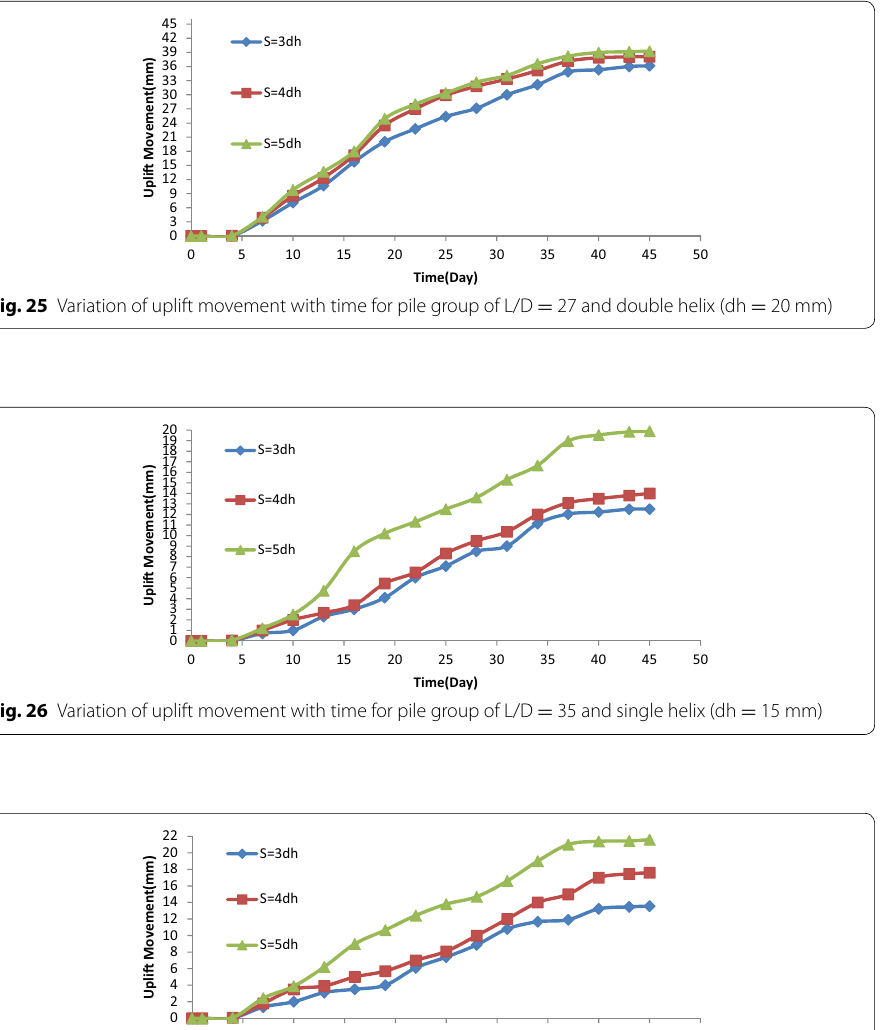
35 and single helix (dh =